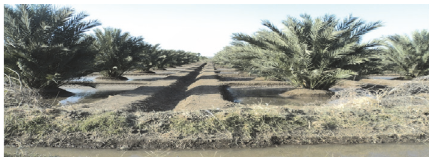
Figure 5: Basin irrigation technology used to irrigate date palm trees in Aysaita District Community Based Research & Demonstra- tion Site (Photos taken during field observation,